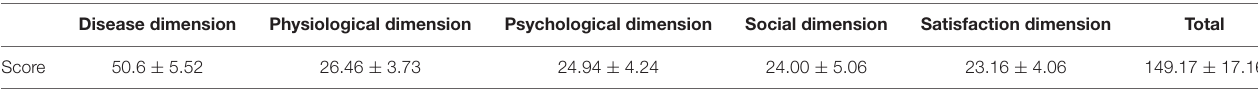
TABLE 3 | QoL in patients with T2DM.